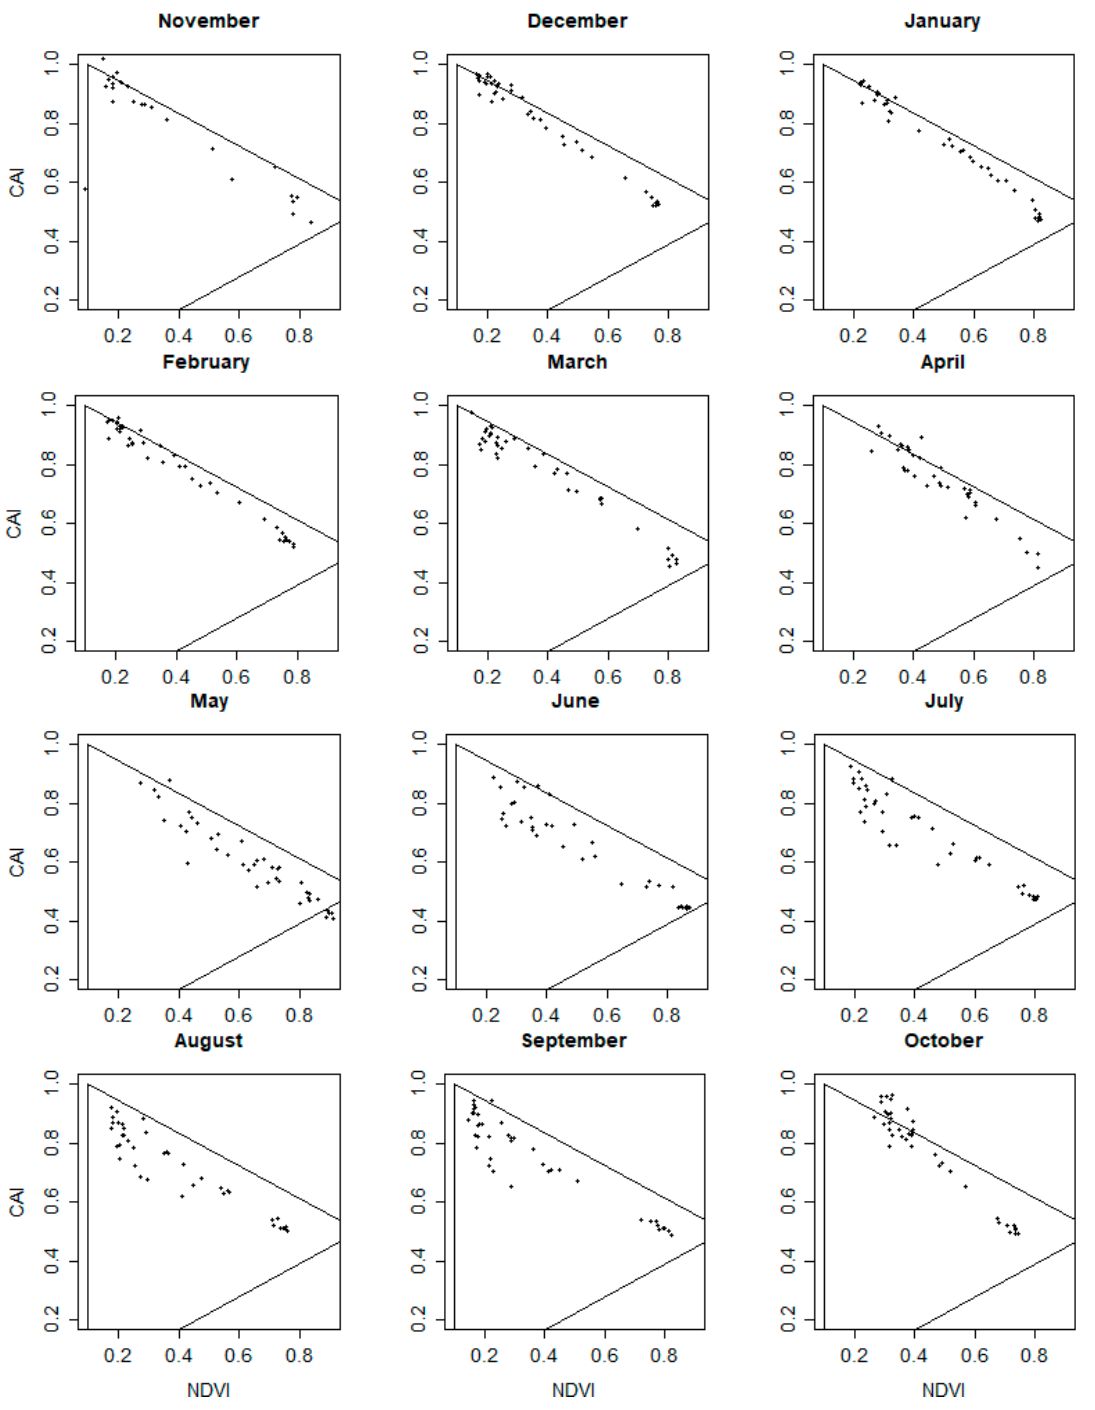
Figure A3. Location of the Tanzanian plots in the NDVI – CAI response space for every month from November 2017 until October 2018. The more the plots verge to the right corner of the triangle, the greener they are, while the upper left corner indicates that more NPV, such as dry and senescent plants, is present in the plots.